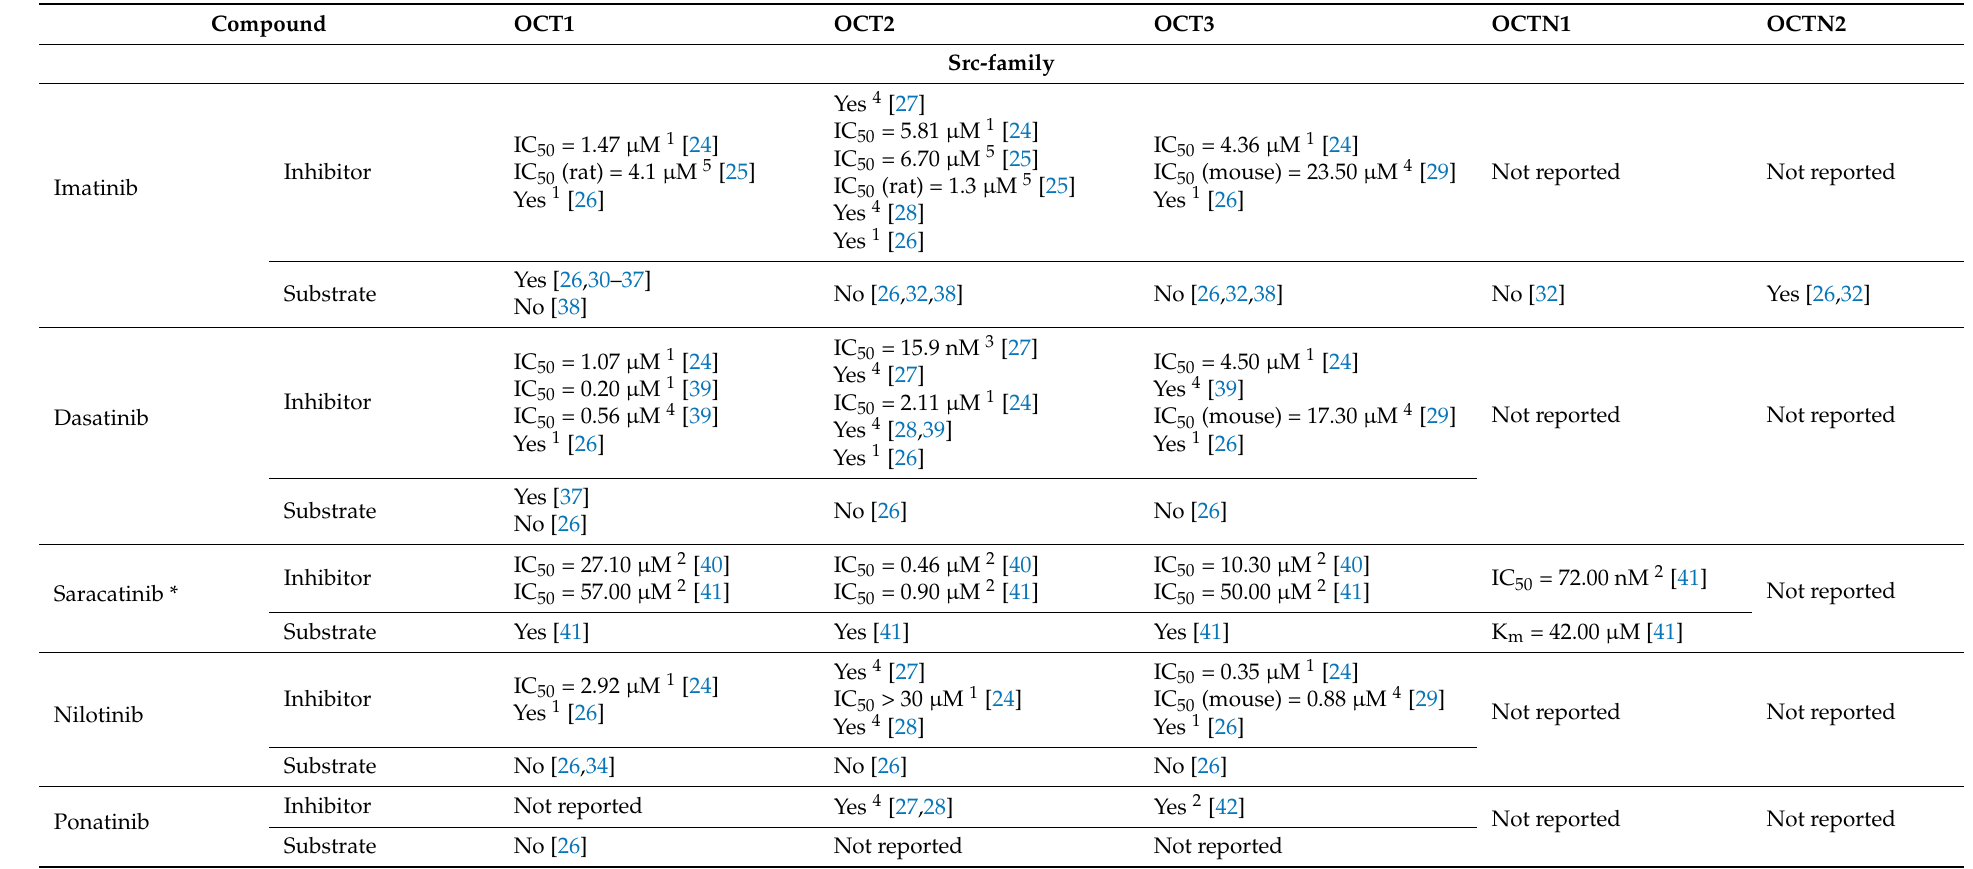
Table 1. OCT–TKI interaction in